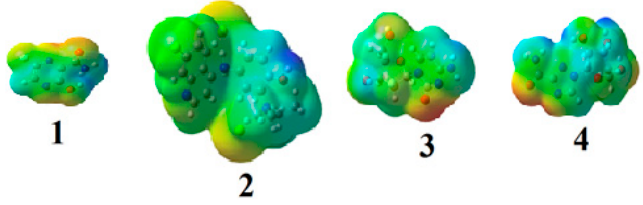
Figure 3. Molecular electrostatic potentials (MEP) of drugs 1 ‒ 4 .